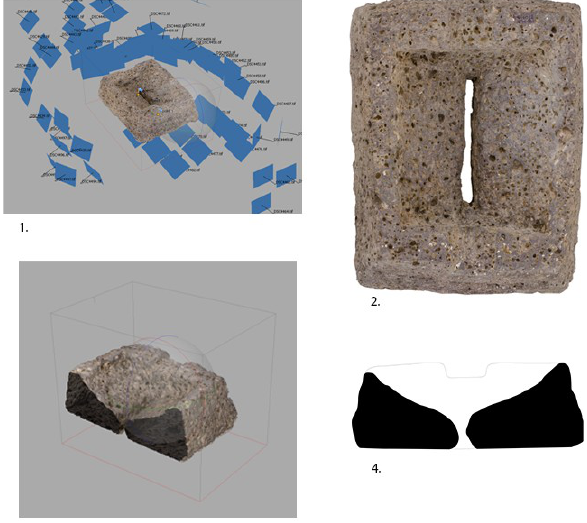
2: Study of a millstone: 1- Textured 3D model; 2- Ortho- image (top view); 3- 3D model segmented; 4- Cross section drawn from the segmented 3D